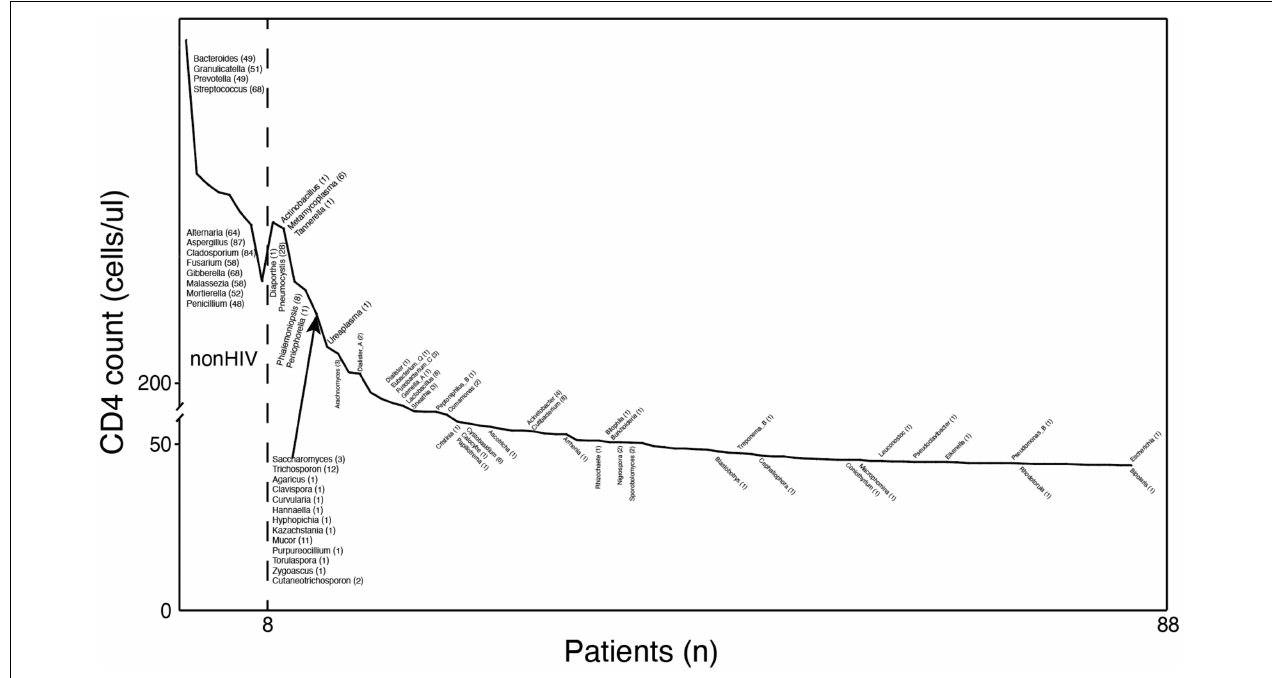
FIGURE 3 | The types of microorganisms in the BALF of HIV-positive individuals increase with decreasing CD4 counts. Profiles of pathogenic microorganisms in HIV/AIDS patients under different immune states. The y -axis coordinate is the CD4 cell count. The x -axis coordinate is a patient at this CD4 value. The text near the curve indicates newly discovered microorganisms at this CD4 value. The numbers in parentheses are the numbers of samples containing the